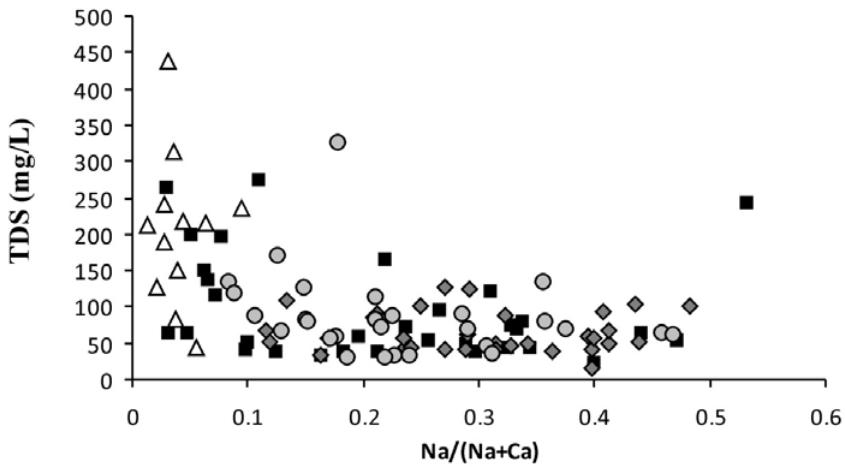
Figure 7. Gibbs plots indicating the mechanisms that determine major ‐ ion composition of the studied waters. Symbols as in Figure